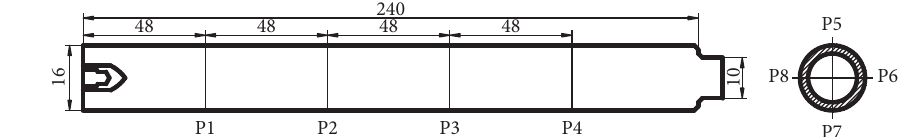
Figure 4: RWT measurement